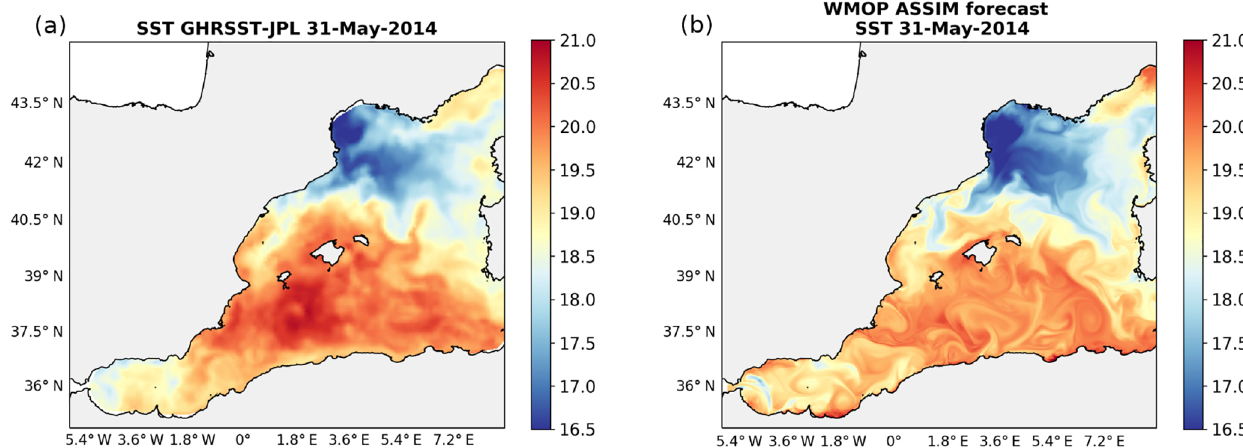
Figure 3. SST for 31 May 2014 from (a) Group for High Resolution Sea Surface Temperature (GHRSST) Jet Propulsion Laboratory (JPL) Multiscale Ultrahigh Resolution (MUR) satellite-derived product and (b) the free-run WMOP